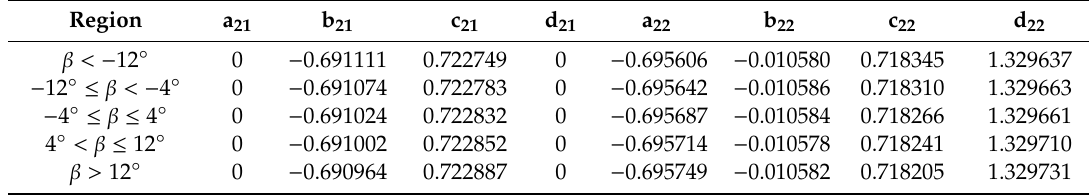
Table 3. The database of intrinsic parameters for the transmitter